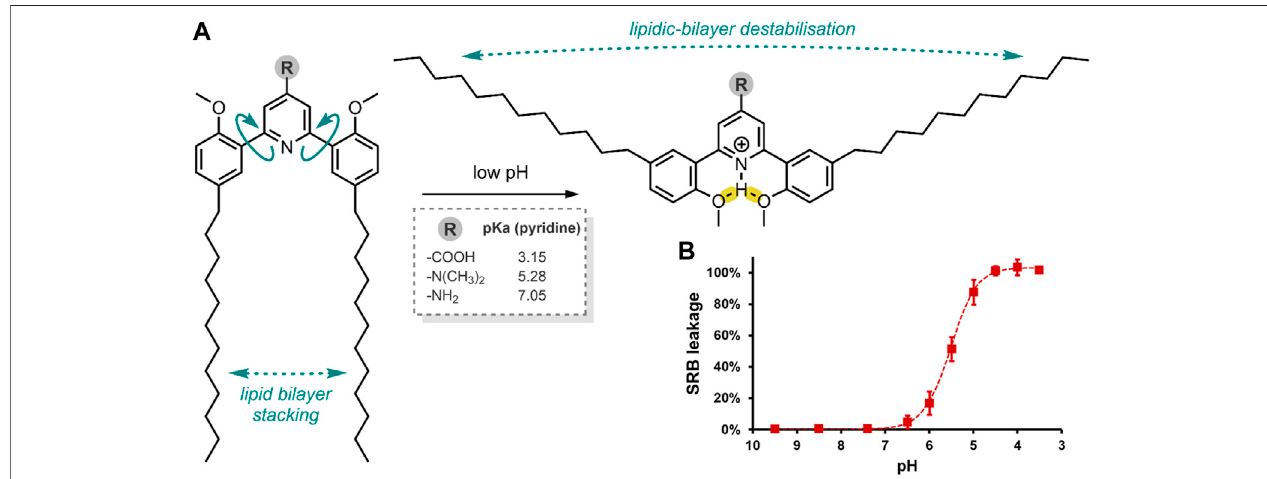
FIGURE 2 | (A) pH-induced conformational change of the alkyl-chain functionalised di(methoxyphenyl)-pyridine molecular switch, resulting in liposome destabilisation and SRB release. Framed : the effect of the R headgroup on pyridine pKa. Hydrogen bonds have been highlighted in yellow (Viricel et al., 2015). (B) SRB leakage from a liposome formulation containing the switch with the – N(CH 3 ) 2 headgroups (75 mol%), at decreasing pH after 15